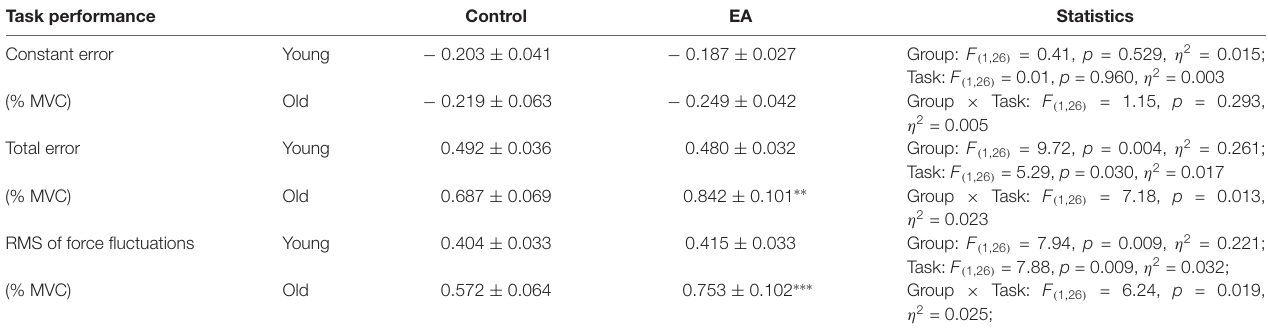
TABLE 1 | The results of analysis of variance (ANOVA) statistics to contrast performance variables between the young and old groups in the control and EA